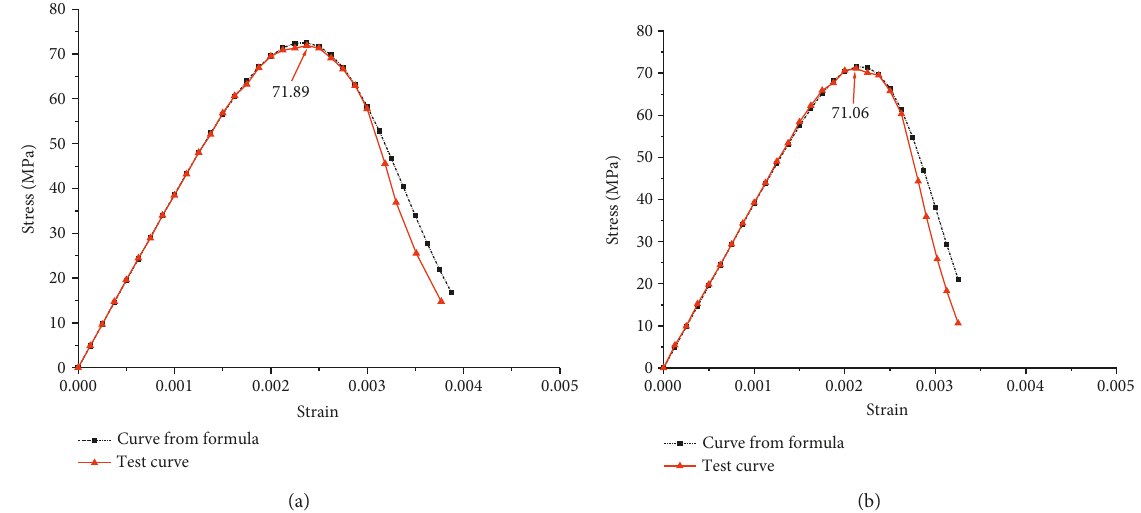
Figure 7: Comparison of test curves and curve from formula of C80 concrete. (a) Internal environment. (b) External environment.